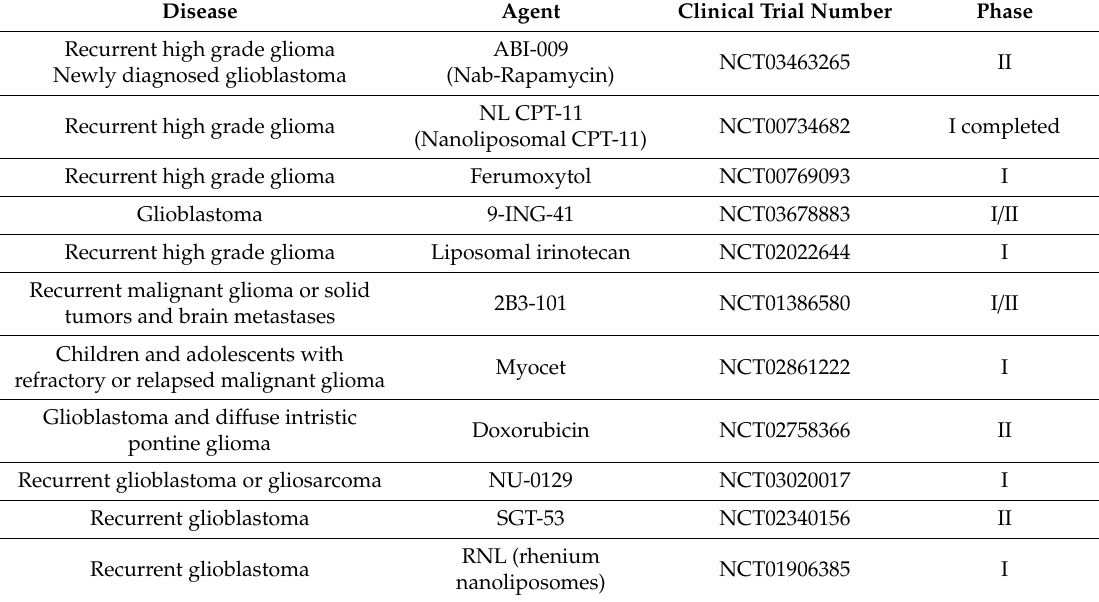
Table 2. A list of glioblastoma clinical trials based on the use of